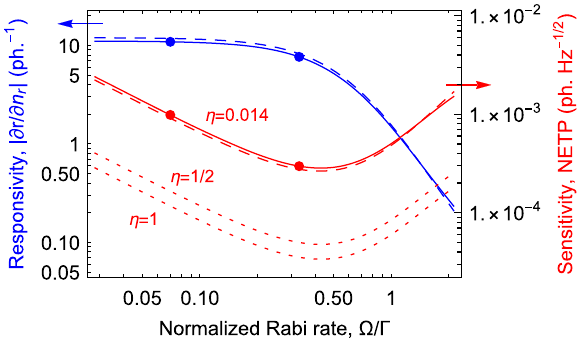
FIG. 5. Calculated photon number responsivity j ∂ r= ∂ n j (left axis) and sensitivity NETP (in photons per square root band- width, right axis) versus normalized Rabi rate Ω = Γ in the low- occupation limit n → 0 and for the measured sample and setup parameters (solid lines). Dashed lines are calculated in the limit Γ = j α j → 0 (see text for details). The dashed lines are the projected sensitivities using the same sample and an amplification chain with efficiencies η ¼ 1 = 2 and η ¼ 1 . Thick dots indicate the responsivity and sensitivity measured with our setup ( η ¼ 0 . 14 ) at the two driving powers used in Fig.